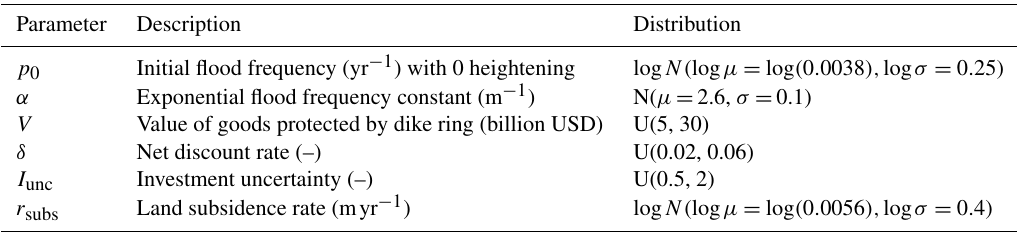
Table 1. Parameter descriptions and prior probability distributions for flood protection cost–benefit analysis. Parameter